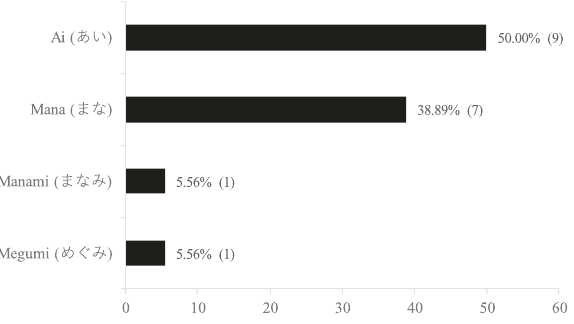
Fig. 7 Variations in readings of the name 愛 . Scores indicate relative frequencies of each reading among the sample ( n = 18). Scores in parentheses indicate the absolute frequencies of each reading.